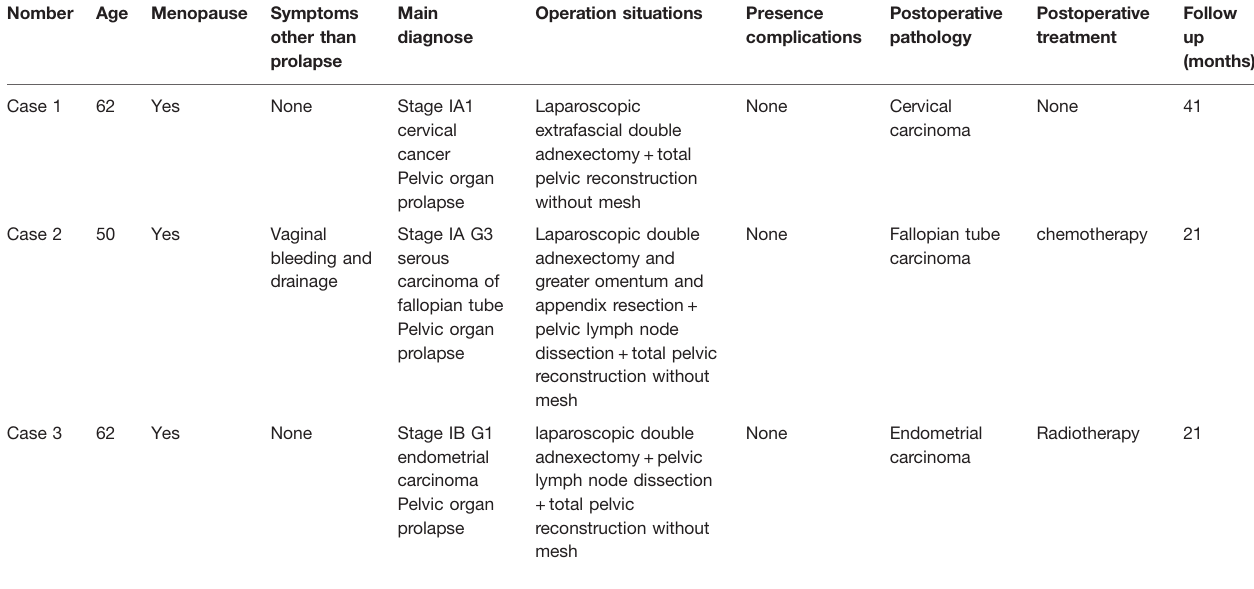
TABLE 1 | The general conditions and operation conditions of the three patients. Nomber Age Menopause Symptoms other